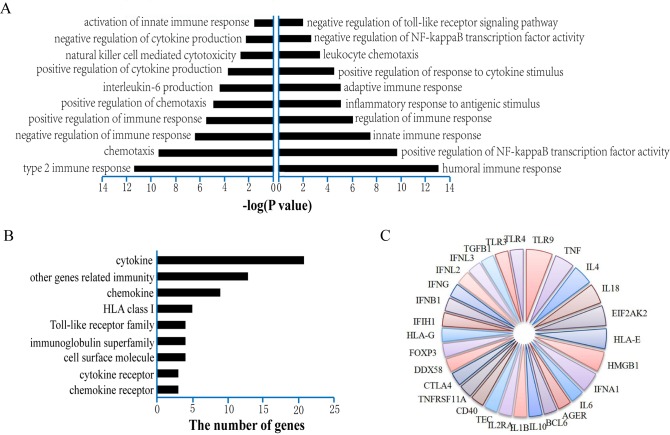
Twenty GO functions of myasthenia gravis.Twenty immune-related GO functions enriched by MG risk genes (P<0.05). (B) Functional classification of MG risk genes in 20 immune-related GO functions. (C) The frequency of MG risk genes in 20 immune-related GO functions.